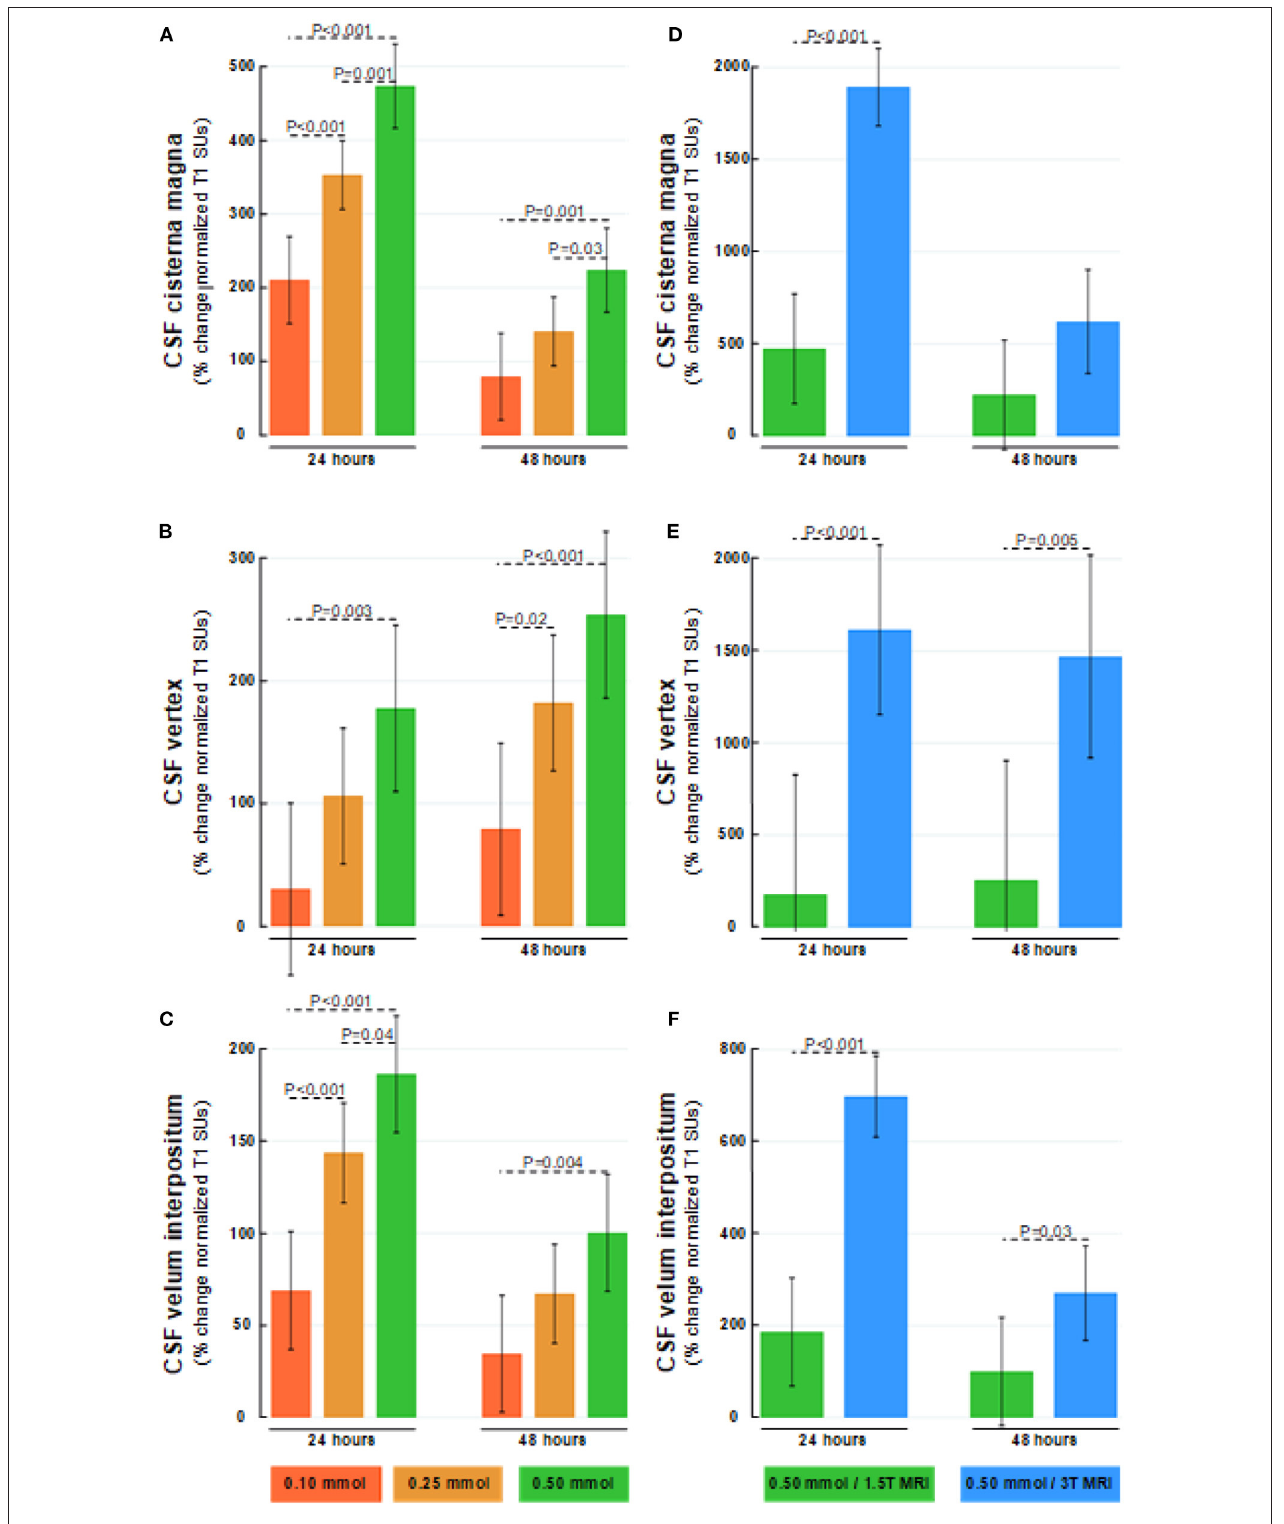
FIGURE 2 | Dose-dependent percentage changes in normalized T1 signal (1.5T MRI scanner) after 24 and 48h are shown for (A) CSF of cisterna magna, (B) CSF at the vertex, and (C) CSF within velum interpositum calculated from FreeSurfer software following intrathecal gadobutrol in doses of 0.10 mmol (red bars), 0.25 mmol (orange bars), and 0.50 mmol (green bars). The normalized T1 signal at 24 and 48h after intrathecal gadobutrol (0.50 mmol) within (D) CSF of cisterna magna, (E) CSF at the vertex, and (F) CSF within velum interpositum are shown for 1.5T (green bars) and 3T MRI scanners (blue bars). The bars show mean and 95% confidence intervals. Differences between groups were determined by mixed model